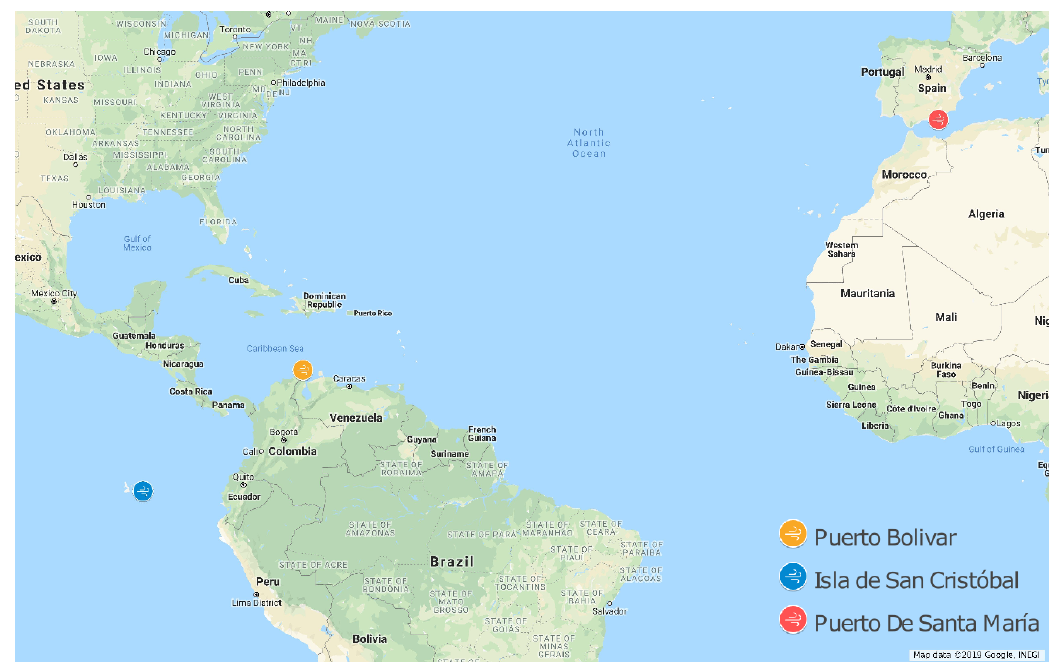
Figure 1. Wind data measurements